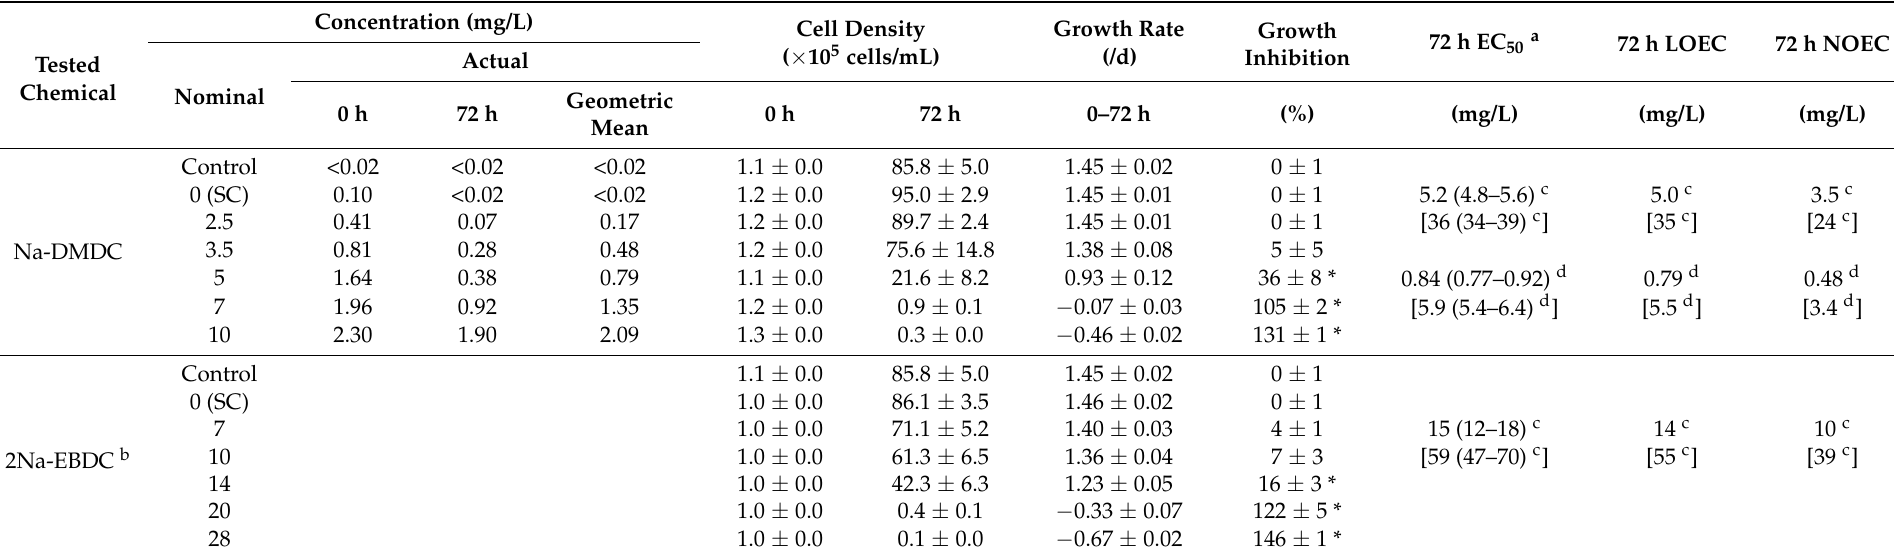
Table 3. Toxicities of the main degradation products of polycarbamate (PC) to the Skeletonema marinoi–dohrnii